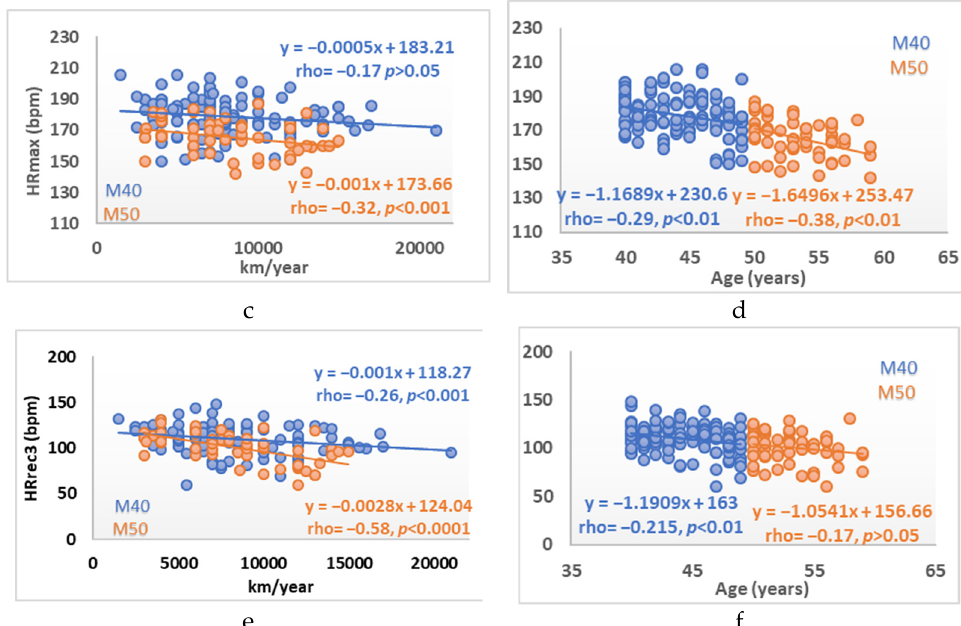
Figure 2. Relationship between heart rate (rest, maximum, and recovery 3 min) variables and km/year cycled ( left column) and age ( right column) ( a ) Resting heart rate versus cycling kilometers, ( b ) Resting heart rate versus age, ( c ) Maximum heart rate versus cycling kilometers, ( d ) Maximum heart rate versus age, ( e ) Heart rate recovery 3 min versus cycling kilometers, ( f ) Heart rate recovery 3 min versus age.